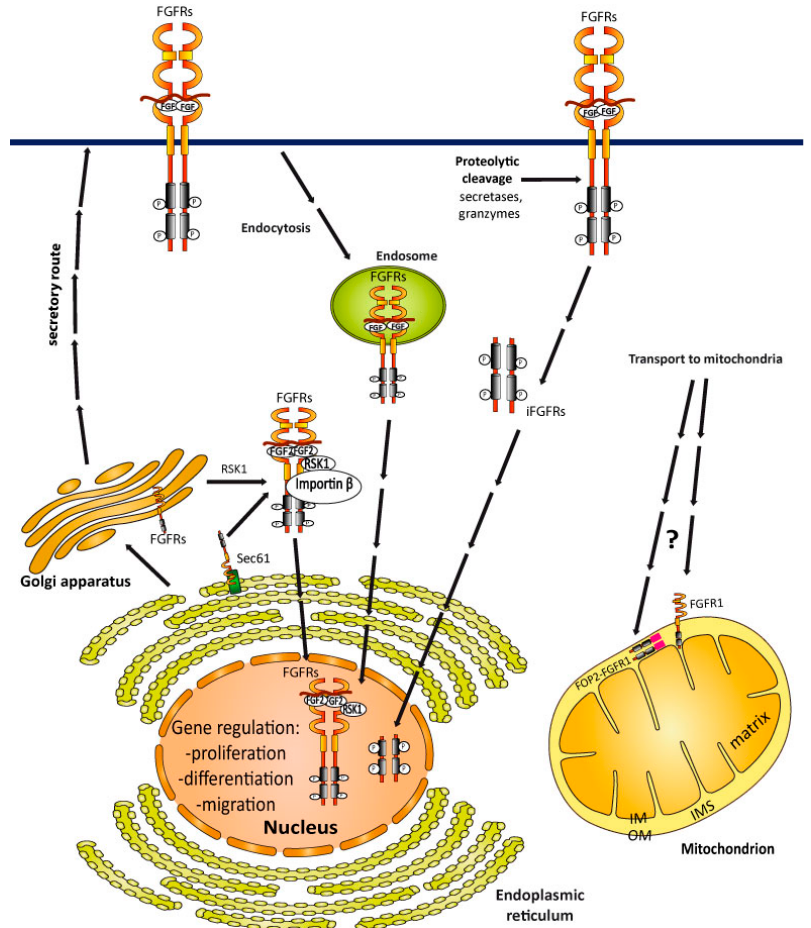
Figure 5. Intracellular transport of FGFRs. FGFRs are synthesized at the ER, where FGFRs enter a secretory route that directs them to the plasma membrane. At the ER/Golgi, FGFRs can retrotranslocate to the cytosol with the help of RSK1 and FGF2, and can subsequently enter the nucleus to directly regulate gene expression. Full length FGFRs can reach the nucleus after endocytosis. Alternatively, proteolytic processing